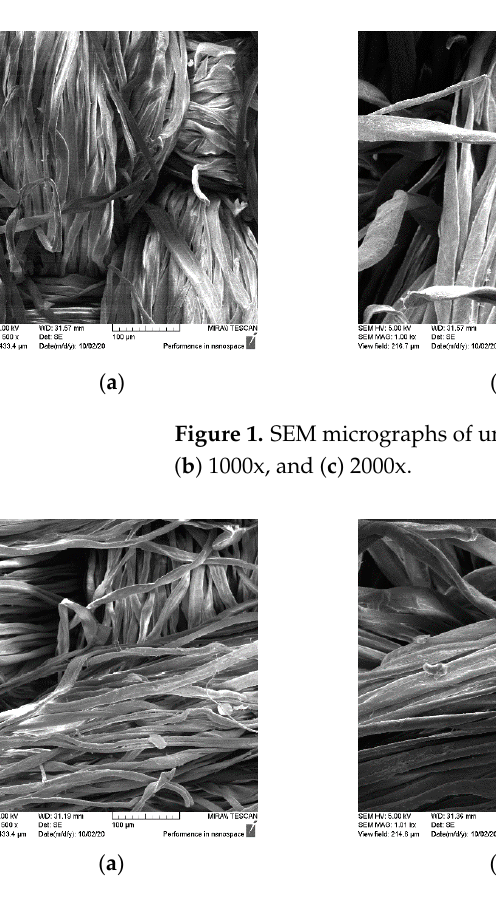
Figure 2. SEM micrographs of untreated satin weave cotton fabric at different magnifications: ( a ) 500x, ( b ) 1000x, and ( c ) 2000x.